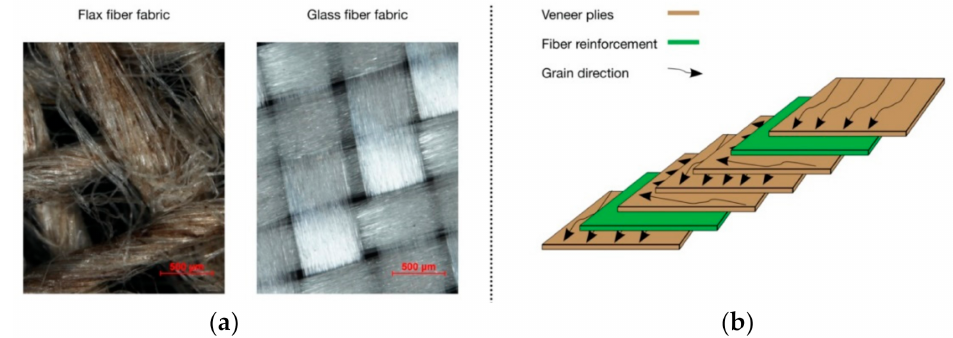
Figure 1. ( a ) Flax fiber vs. glass fiber fabric ( b ) Lay up of 5 × 90 ◦ reinforced